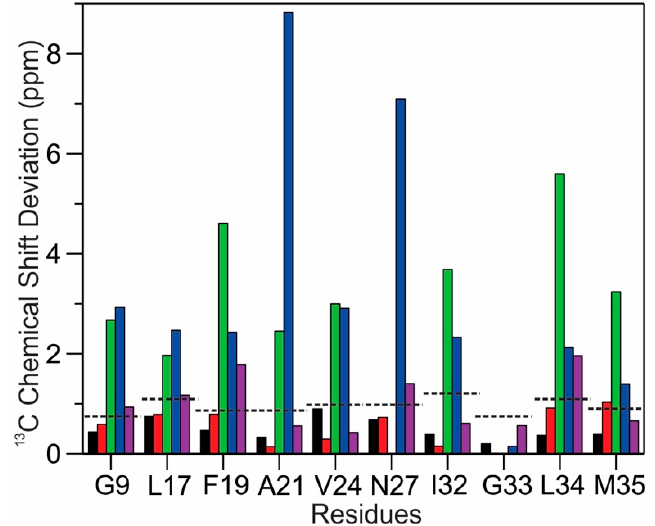
Figure 5. Plot of the residue-specific 13 C chemical shift deviation for membrane-associated A β 40 fibrils derived from MM1 (the fibrils grown from phosphatidylcholine (PC) model bilayers). The comparison contains two types of fibrils from current studies: those grown from the MM2 model bilayer (black) and those grown from the extracted synaptic membranes BM2 (red), and three fibrils reported in the literature: the three-fold A β 40 fibrils grown from synthetic peptides (green) [35], the first molecular structure from human-brain-seeded A β 40 fibril (blue) [6] and the reported predominant structure from multiple human brain tissue samples (purple) [8]. The dashed lines represent the thresholds of significant chemical shift difference for individual residues, by considering the ssNMR line widths.